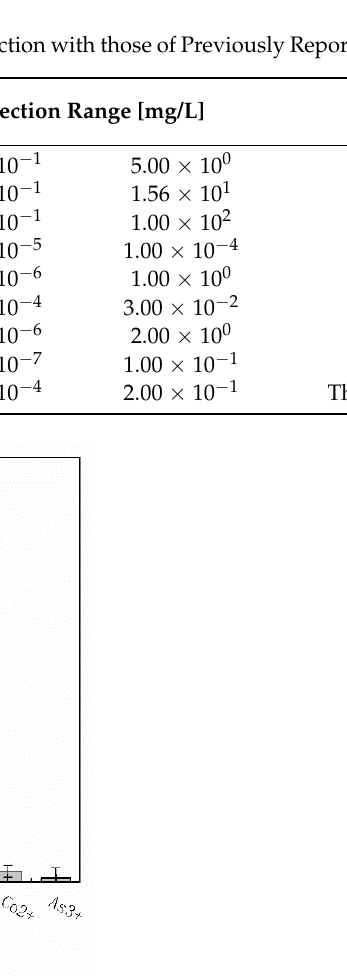
Figure 5. Detection of DEHP in aquatic wastewater samples. A total of 10 µL of wastewater samples containing 1, 2, 4, 8, 12, 16, and 20 µg/L DEHP were analyzed, and the fluorescence variable curves